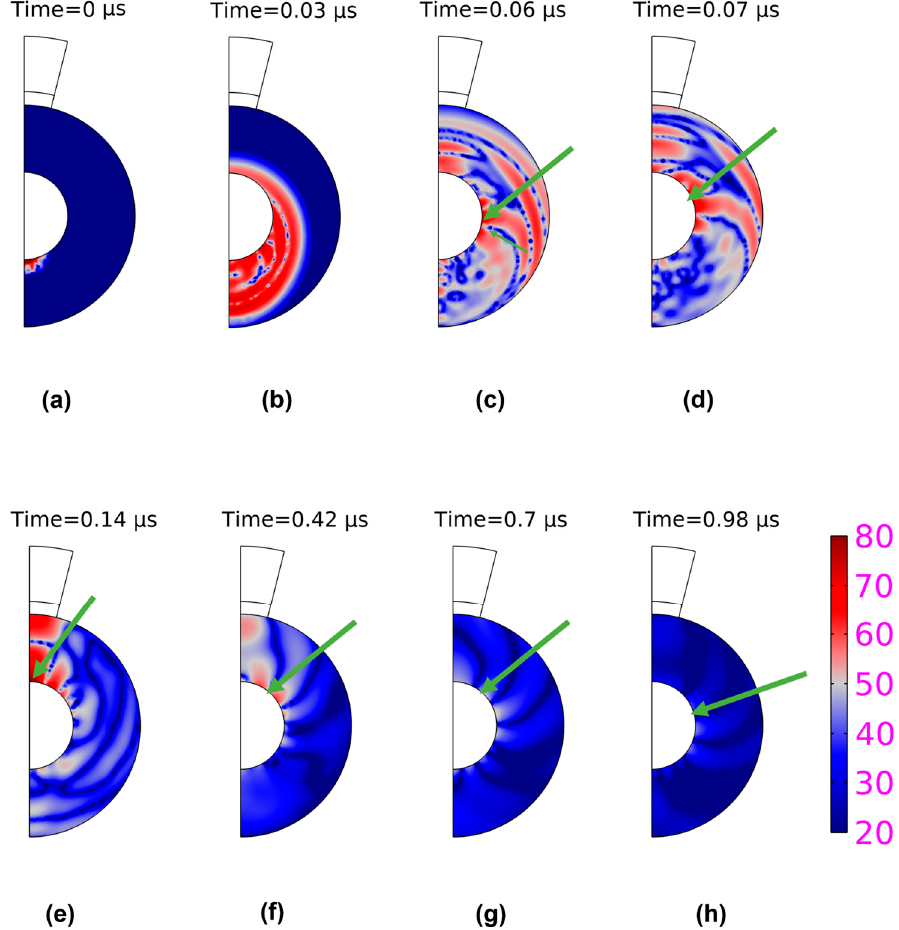
Figure 6. Spatial distributions of the pressure amplitude at eight different times generated from the numerical computation using a PS80 particle. The times are chosen to illustrate both the initial period with strong contribution from bulk waves ( a – c ) and remaining times ( d – h ) where Scholte waves becomes gradually more important. For figures where the Scholte wavelets could be identified, its centre is indicated with a green arrow. The time interval between the latter figures is chosen in accordance with the estimated wave period 0.28 µs for Scholte waves, to study the interface as it orbits several times around the microsphere. The used colormap similar for all figures shows the computed pressure in units Pascal a dB